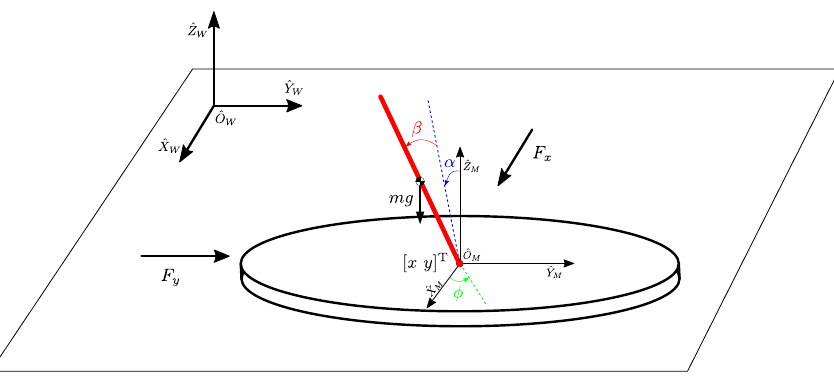
Figure 4. Spherical inverted